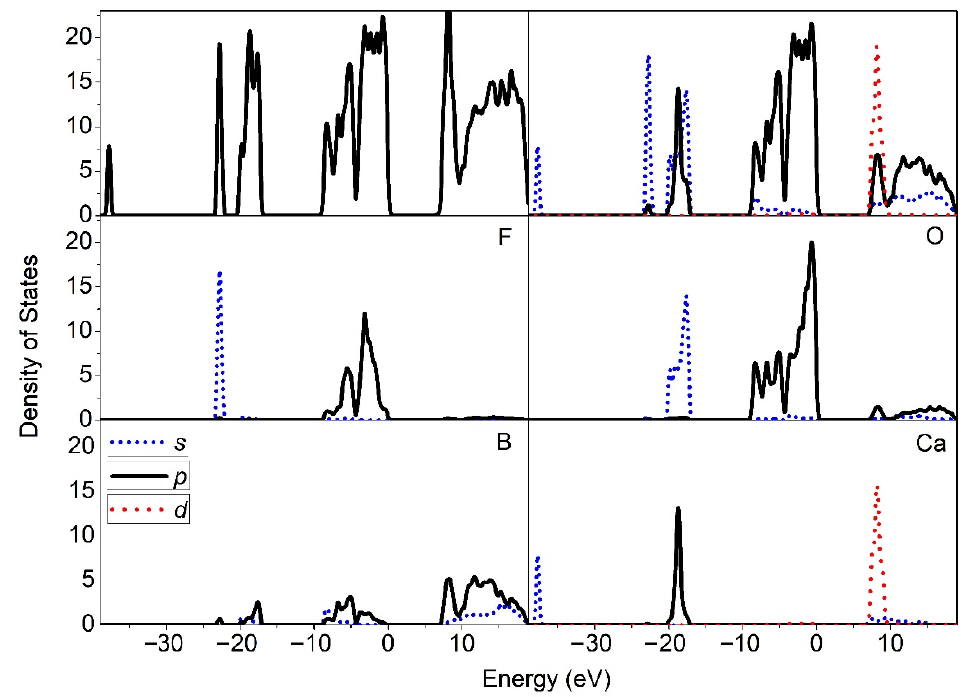
Figure 3. The total density of states (DOS) and the partial density of states (LDOS) for atoms O, F, B, and Ca.